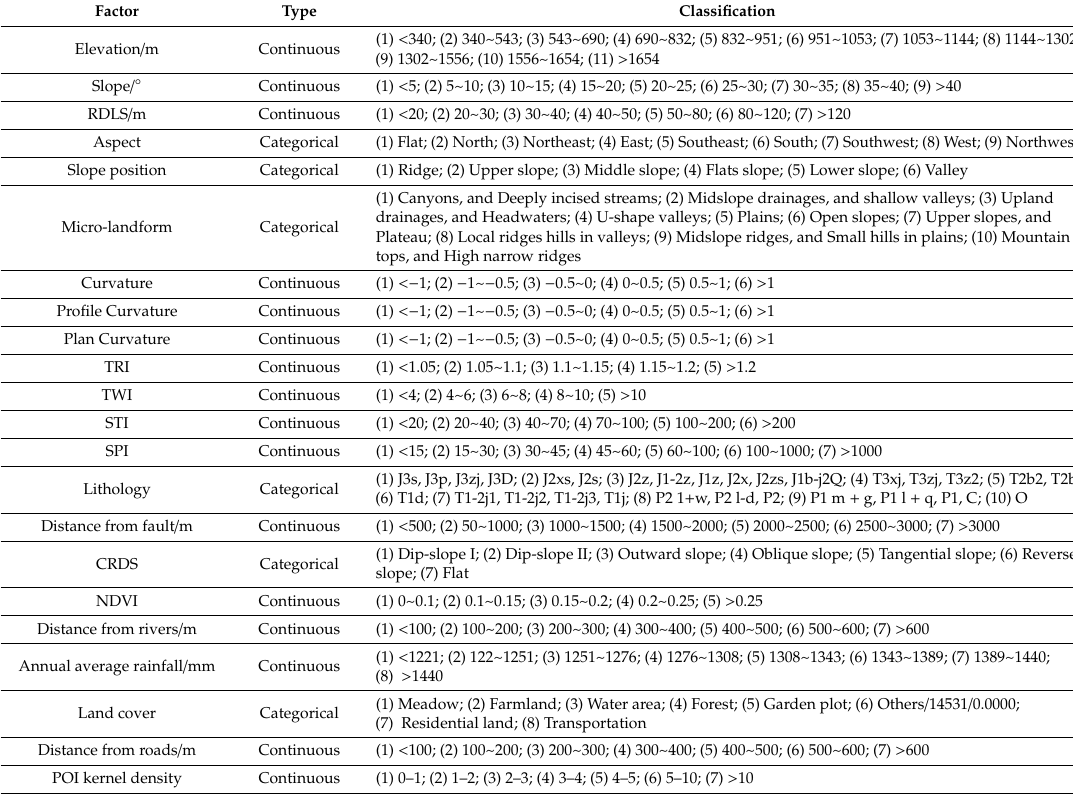
Table 1. Classification of conditioning